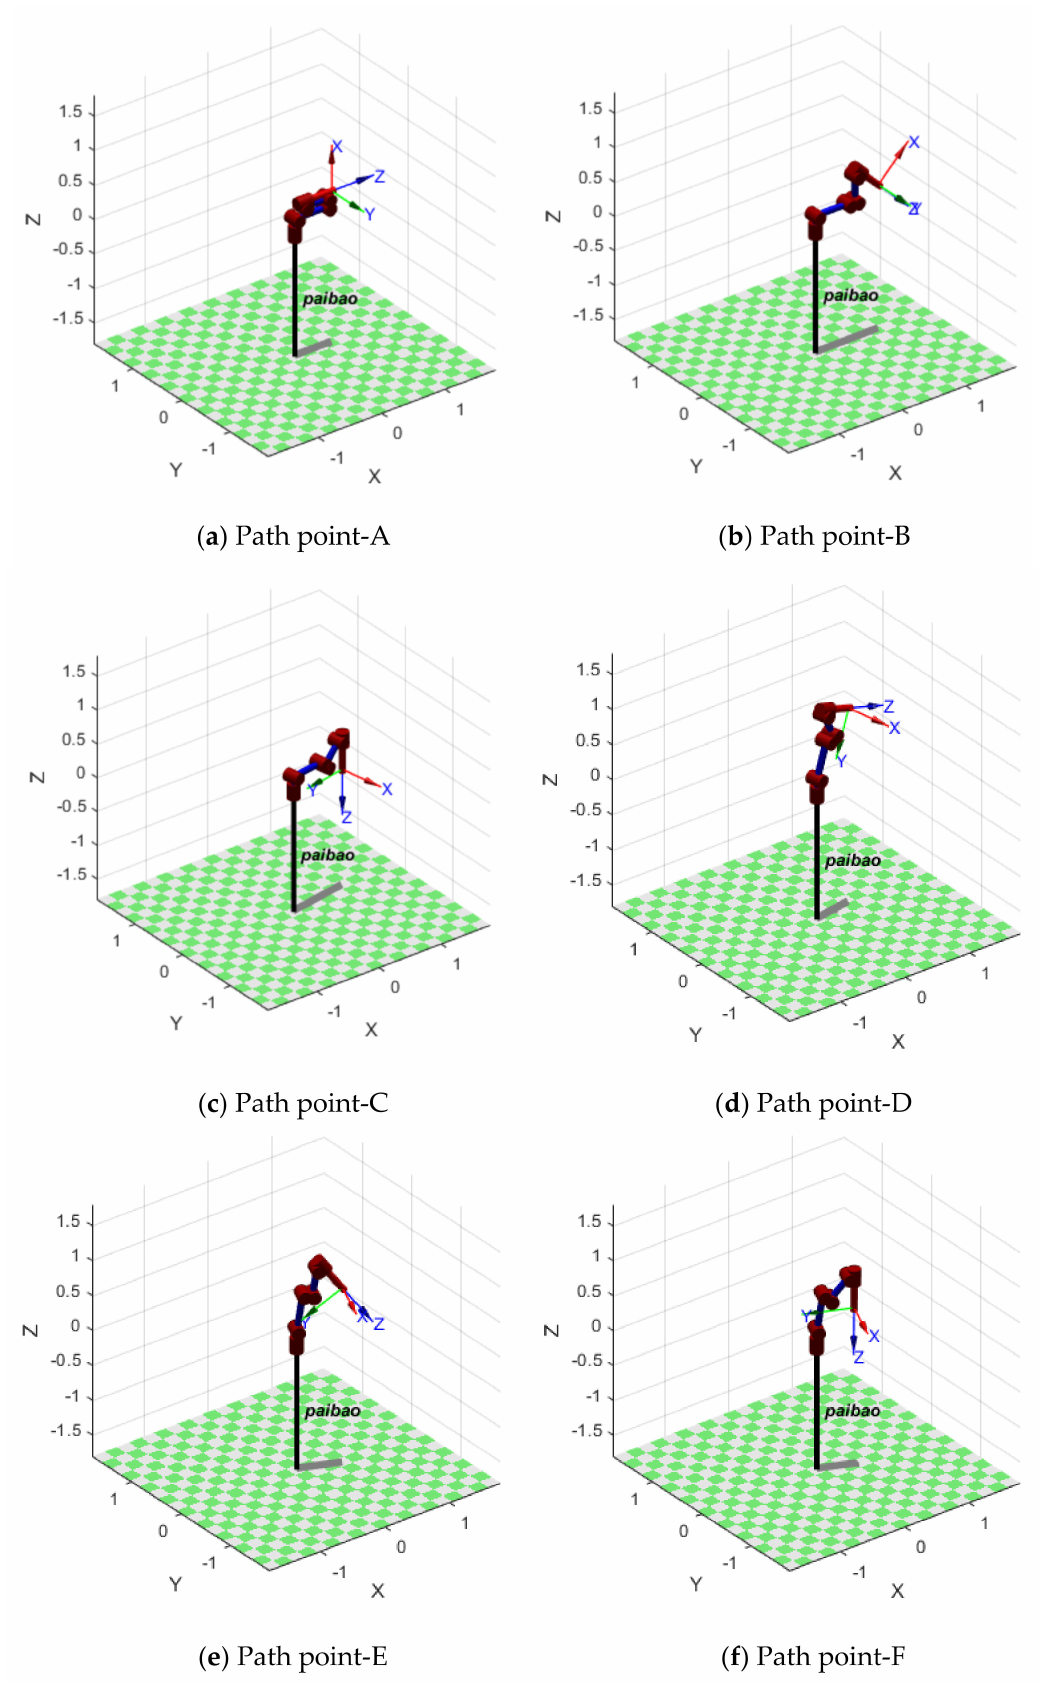
Figure 19. The simulated trajectory of each point of the